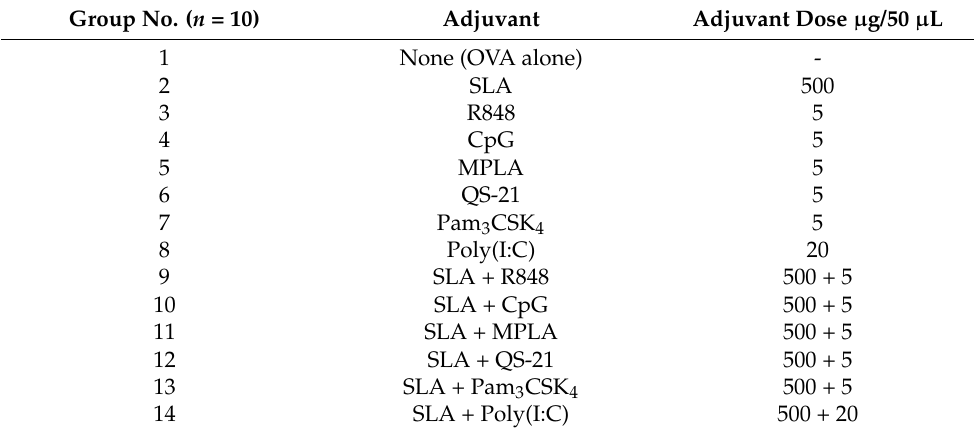
Table 1. Vaccine formulations using model antigen ovalbumin (OVA) as antigen.